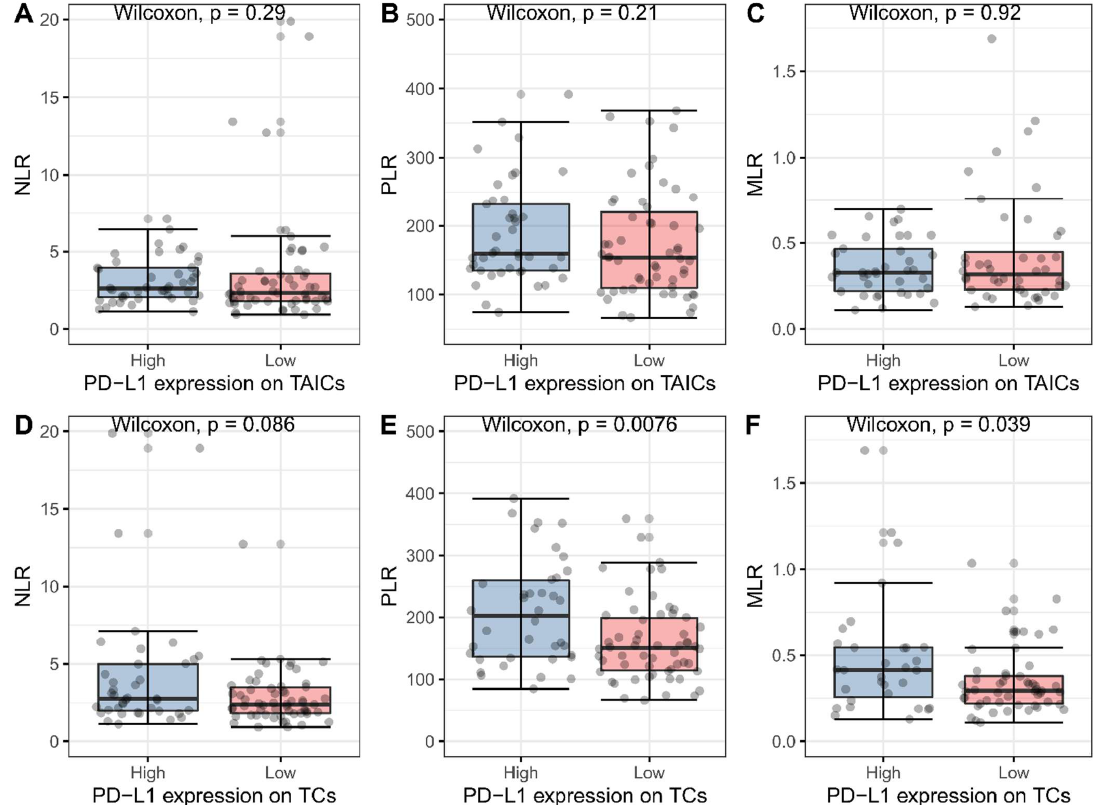
Figure 2. Associations between markers of systemic inflammation and PD-L1 expression on tumor- associated immune cells (TAICs) ( A – C ) and tumor cells (TCs) ( D – F ). Blue and red boxes represent high and low expression of PD-L1, respectively. Grey dots represent individual measures. Table 2. Median and interquartile (IQR) values for markers of systemic inflammation: